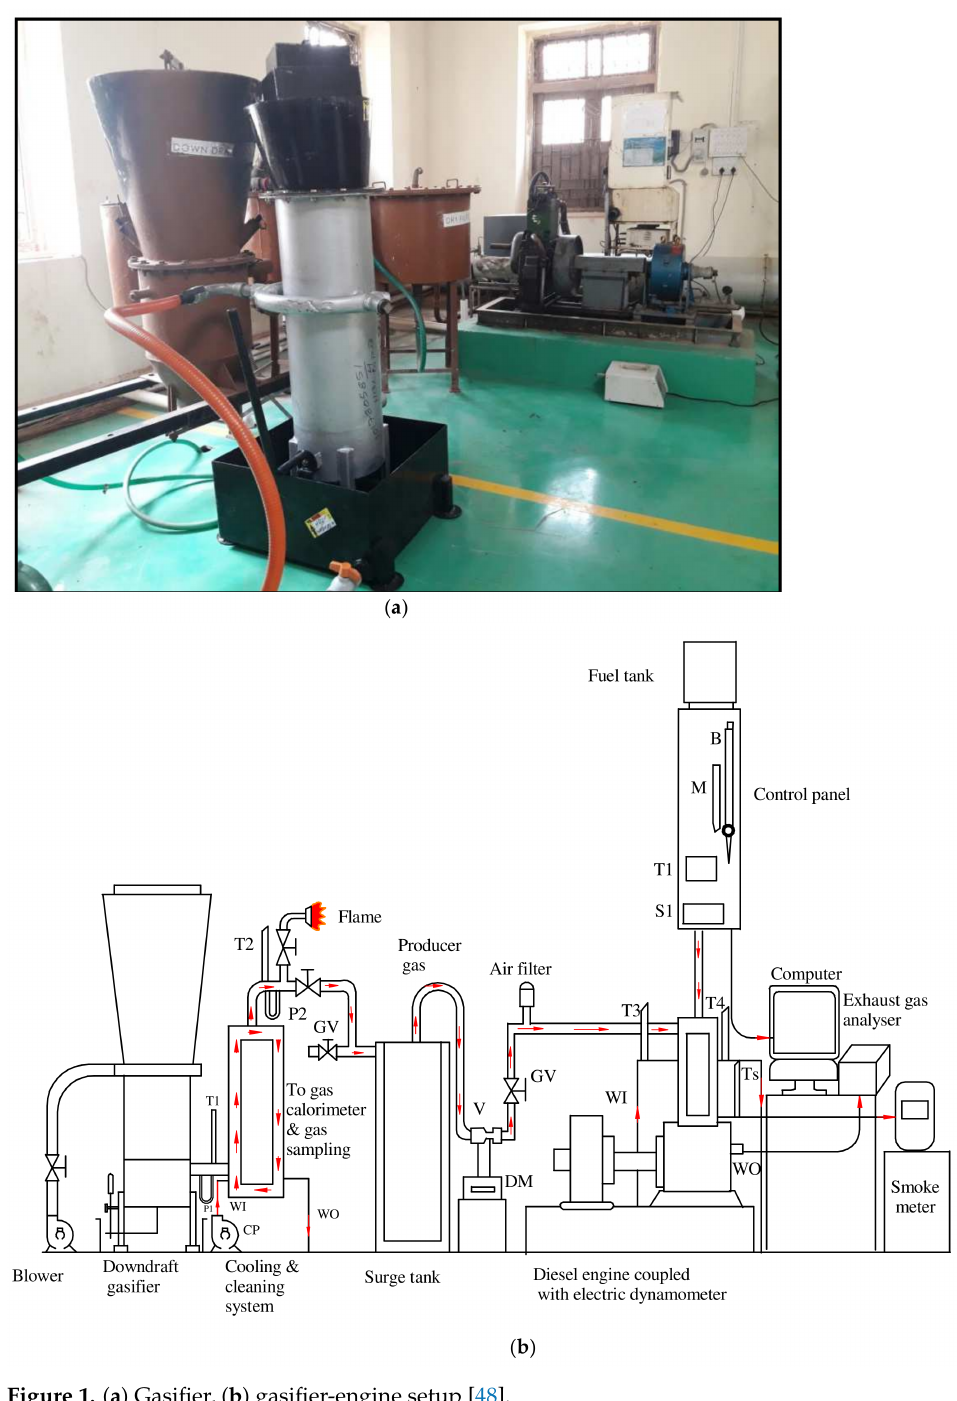
Figure 1. ( a ) Gasifier, ( b ) gasifier-engine setup